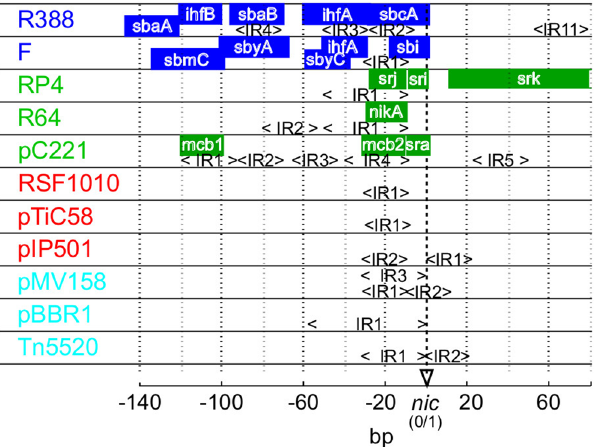
Figure 1. Schematic representation of available experimental data on oriT regions from four MOB groups. o riT data from MOB F (blue), P (green), Q (red) and V (cyan) supports that the conservation of structural properties within each MOB group is greater than between groups. Known binding sites for auxiliary proteins and relaxases are marked (colored squares) and are frequently characterized by inverted repeats ( < IR > ). Relaxase binding sites are nearest to the nic site (between 0 and 1 bp). General characteristics of MOB groups are: (F) system of multiple auxiliary proteins including the DNA-bending protein IHF 44,55 , (P) up to 5 proteins including relaxase involved in relaxation (RP4) 47,54,61 (Q) a shorter oriT region of only 38 bp that covers besides relaxase 2